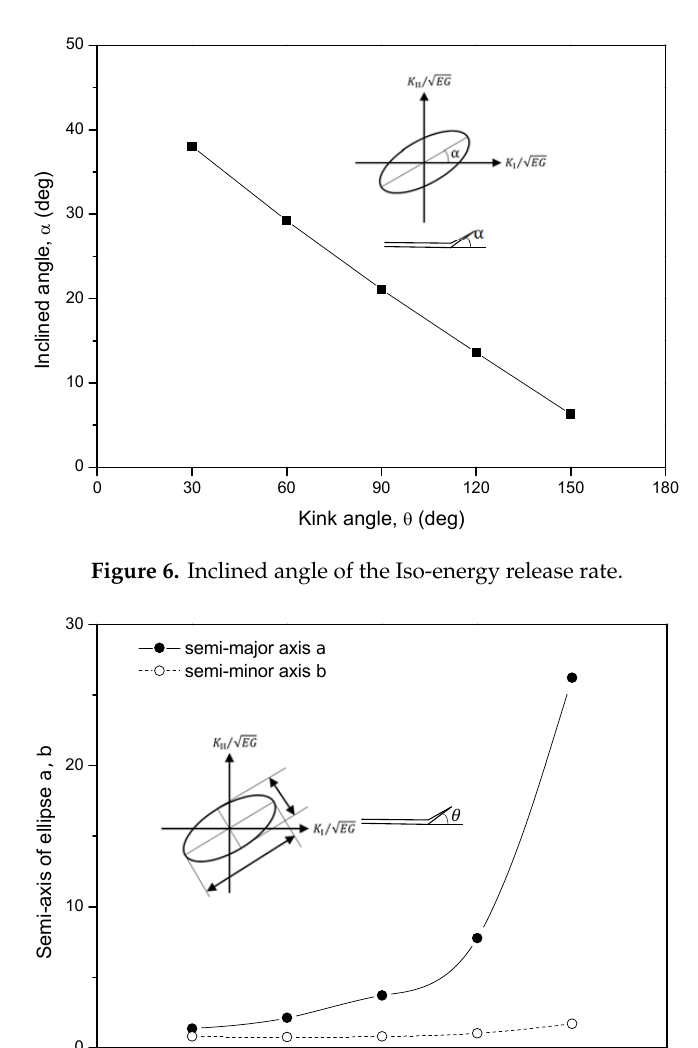
Figure 5. Iso ‐ energy release rate ellipses on normalized mixed mode stress intensity factors.